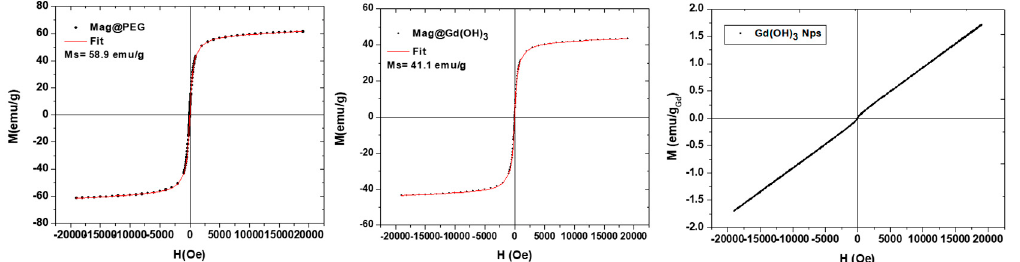
Figure 8. VSM measurements of the raw and hybrid